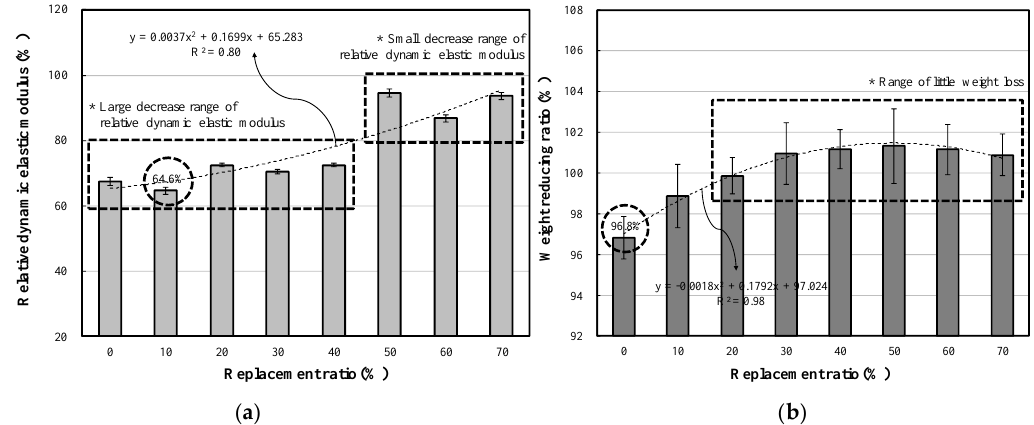
Figure 15. ( a ) Relative dynamic elastic modulus and ( b ) weight reducing ratio relative to the replacement ratio.